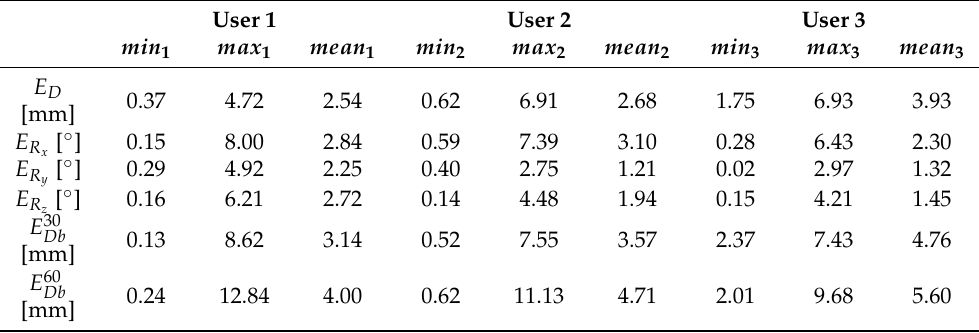
, E R , and E R are the Euler x y z and E 60 represent the drill target errors for Db Db